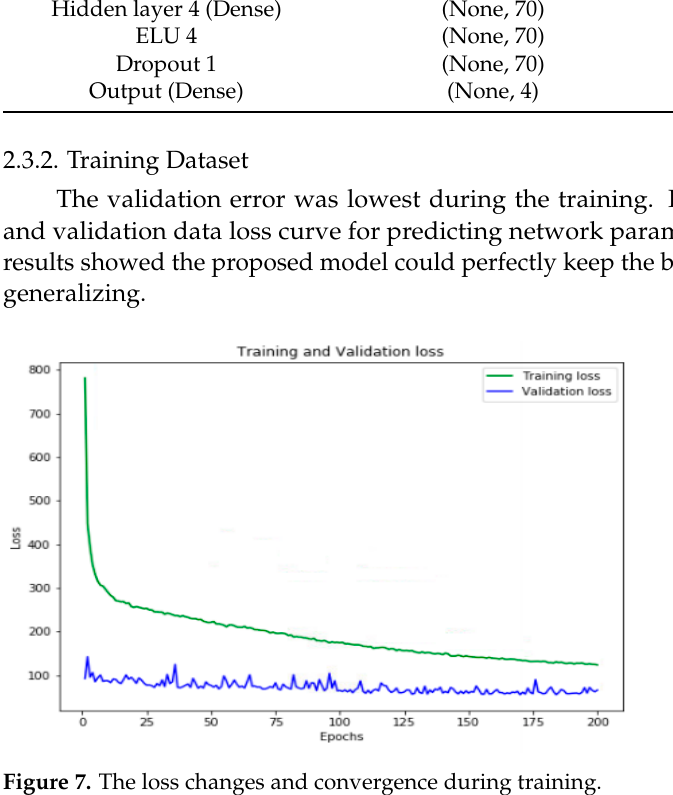
Figure 7. The loss changes and convergence during training.